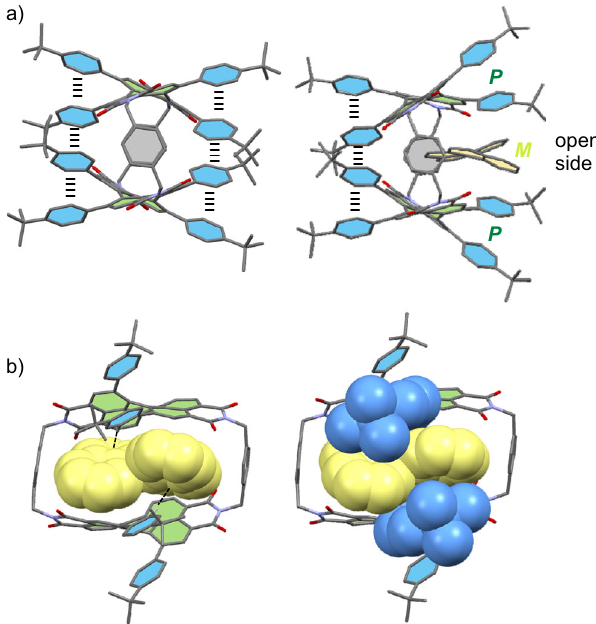
Fig. 5 | DFT calculations. DFT calculated structure of ( a ) 1- PP and M -[5]helicene ⊂ 1- PP fromthefrontviewwithindicated π − π stackingofphenylsubstituentsand( b ) side viewof M -[5]helicene ⊂ 1- PP (baysubstituents are partially omitted for clarity). ThecoreofthePBIunitsandthebaysubstituentsarehighlightedingreenandblue, respectively. The guest is highlighted in yellow. Hydrogen atoms are omitted for